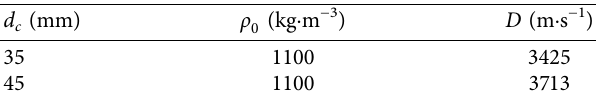
Table 1: Detonation velocities of explosives with different diameters.